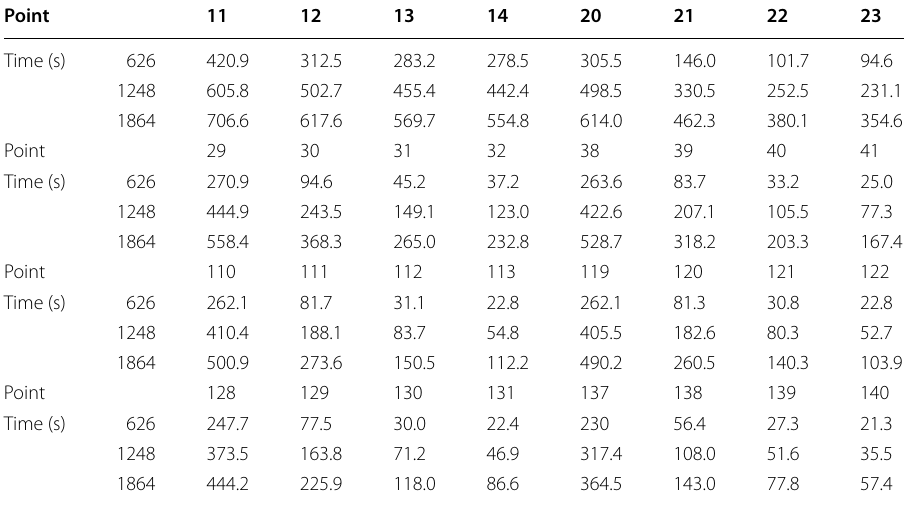
Table 6 Fire scenario 2: Temperature at various sections of the beam Point 11 12 13 Time (s)